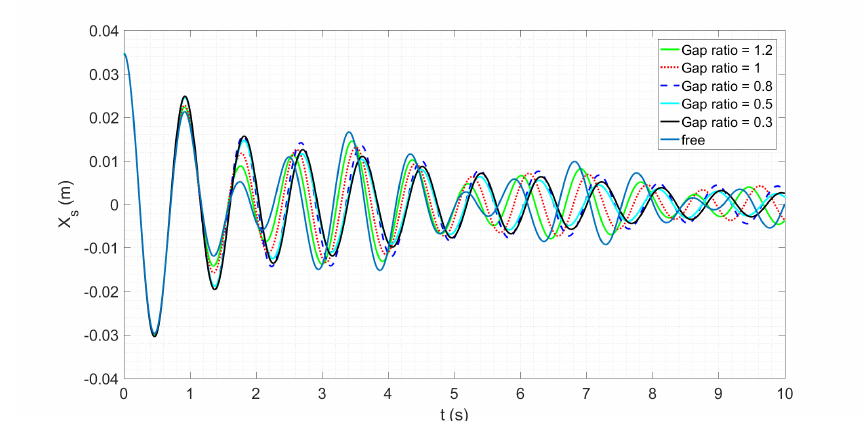
Figure 6. Structure position under different gap distances.